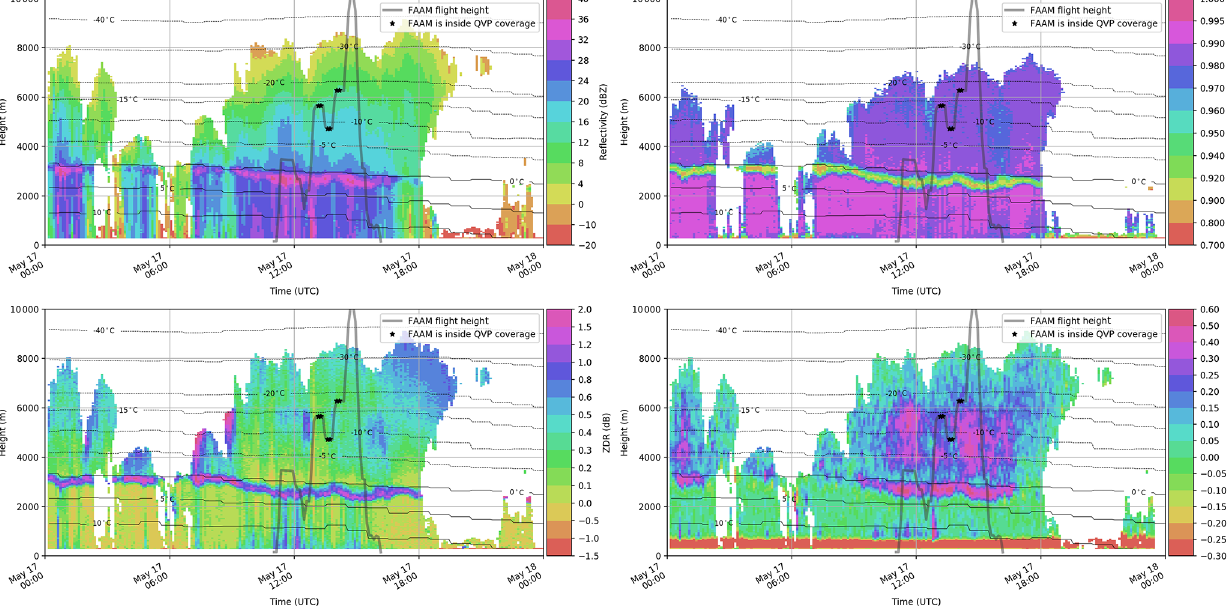
Figure 2. The height vs. time QVPs of Z H [dBZ], Z DR [dB], ρ HV [–] and K DP [ ◦ km − 1 ] retrieved from the NXPol radar observations at Chilbolton on 17 May 2017. Overlaid by temperature isotherms T [ ◦